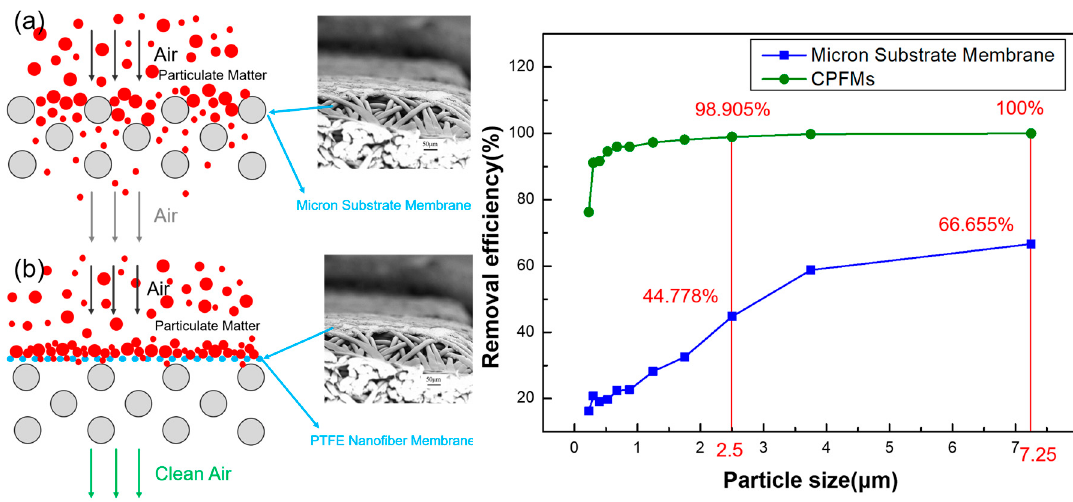
Figure 9. CPFMs used in air filtration to removal particulate matter and the measured removal efficiency. ( a ) Schematic diagram of micron substrate membrane filter. ( b ) Schematic diagram of CPFMs filter. ( c ) The removal efficiency of micron substrate membrane and CPFMs for different particle sizes.